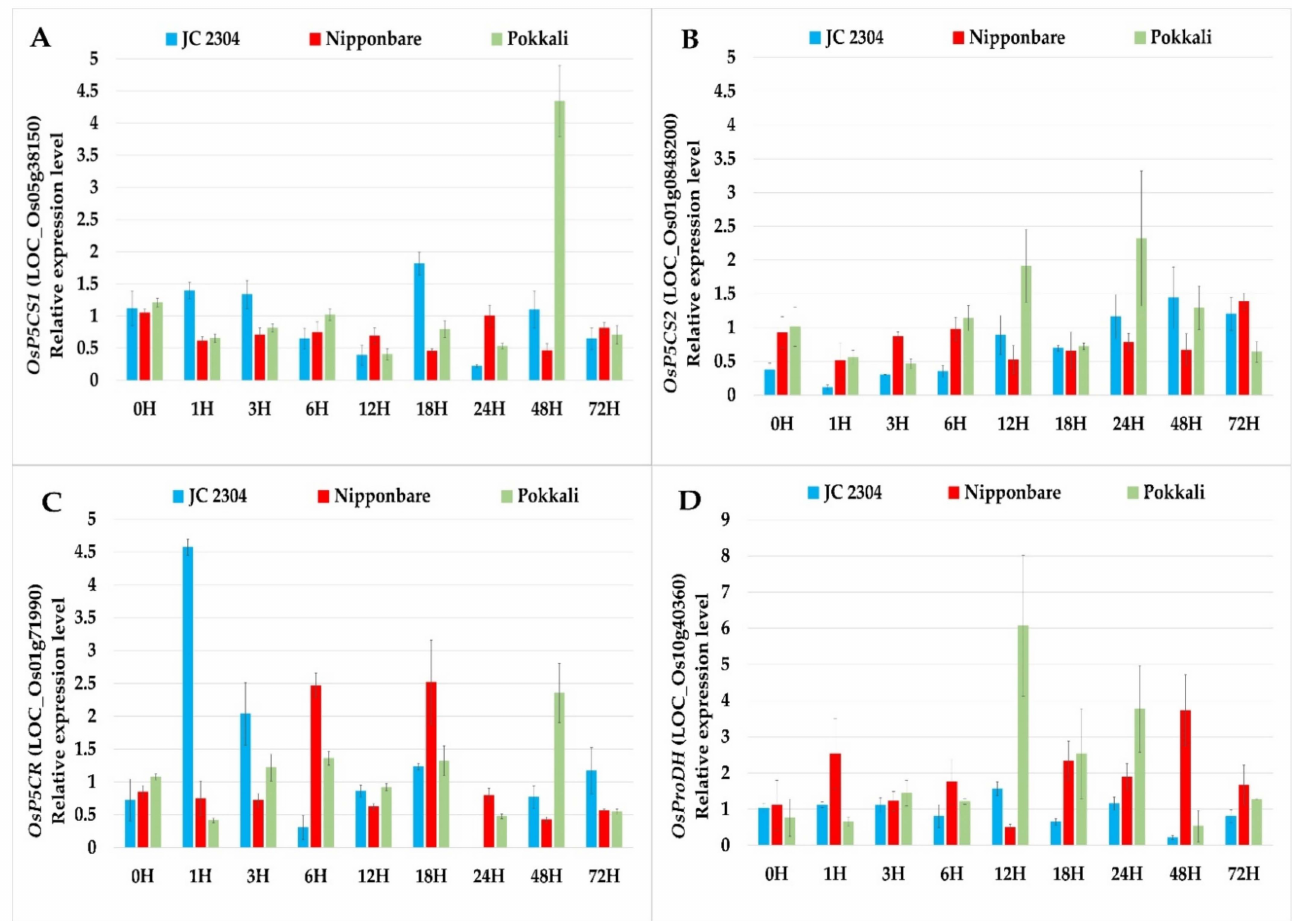
Figure 2. Effects of salinity stress (150 mM NaCL) on relative expression of proline metabolism genes in wild and cultivated rice. The relative expression was quantified as fold change in leaf tissue of cultivated rice ( O. sativa ) and wild rice ( O. australiensis ) by quantitative Real-Time PCR (qRT-PCR). ( A ) OsP5CS1 . ( B ) OsP5CS2 . ( C ) OsP5CR . ( D ) OsProDH . Levels of the transcript were normalized to two internal reference genes OsAct and OsEF-1 α . Expression levels of genes in salt-stressed plants were normalized with respect to those in non-stressed plants. Data represent the means ± SE ( n = 9).